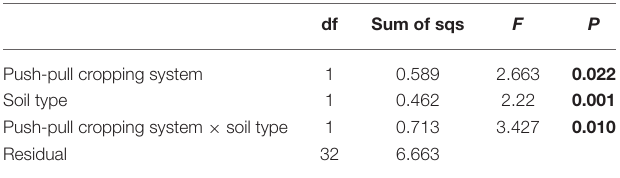
TABLE 1 | Results of PERMANOVA comparing the effects of push-pull companion cropping technology, soil type, and their interaction on the overall volatile organic compounds composition and quantities produced by maize plant grown in soil conditioned by different cropping systems.